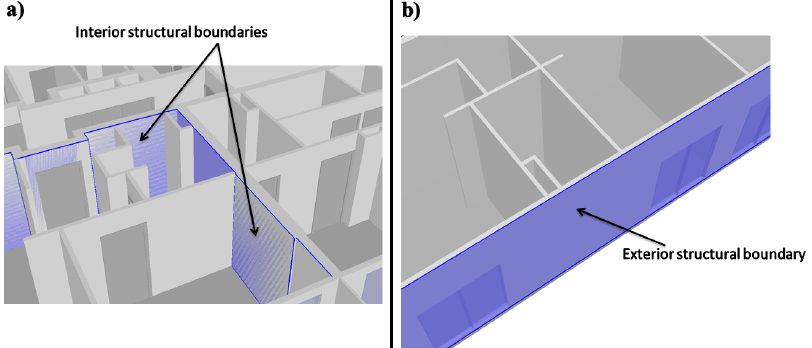
Figure 12. Examples of the legal boundaries represented in the purely physical model: ( a ) Internal wall boundaries; ( b ) External wall boundary.